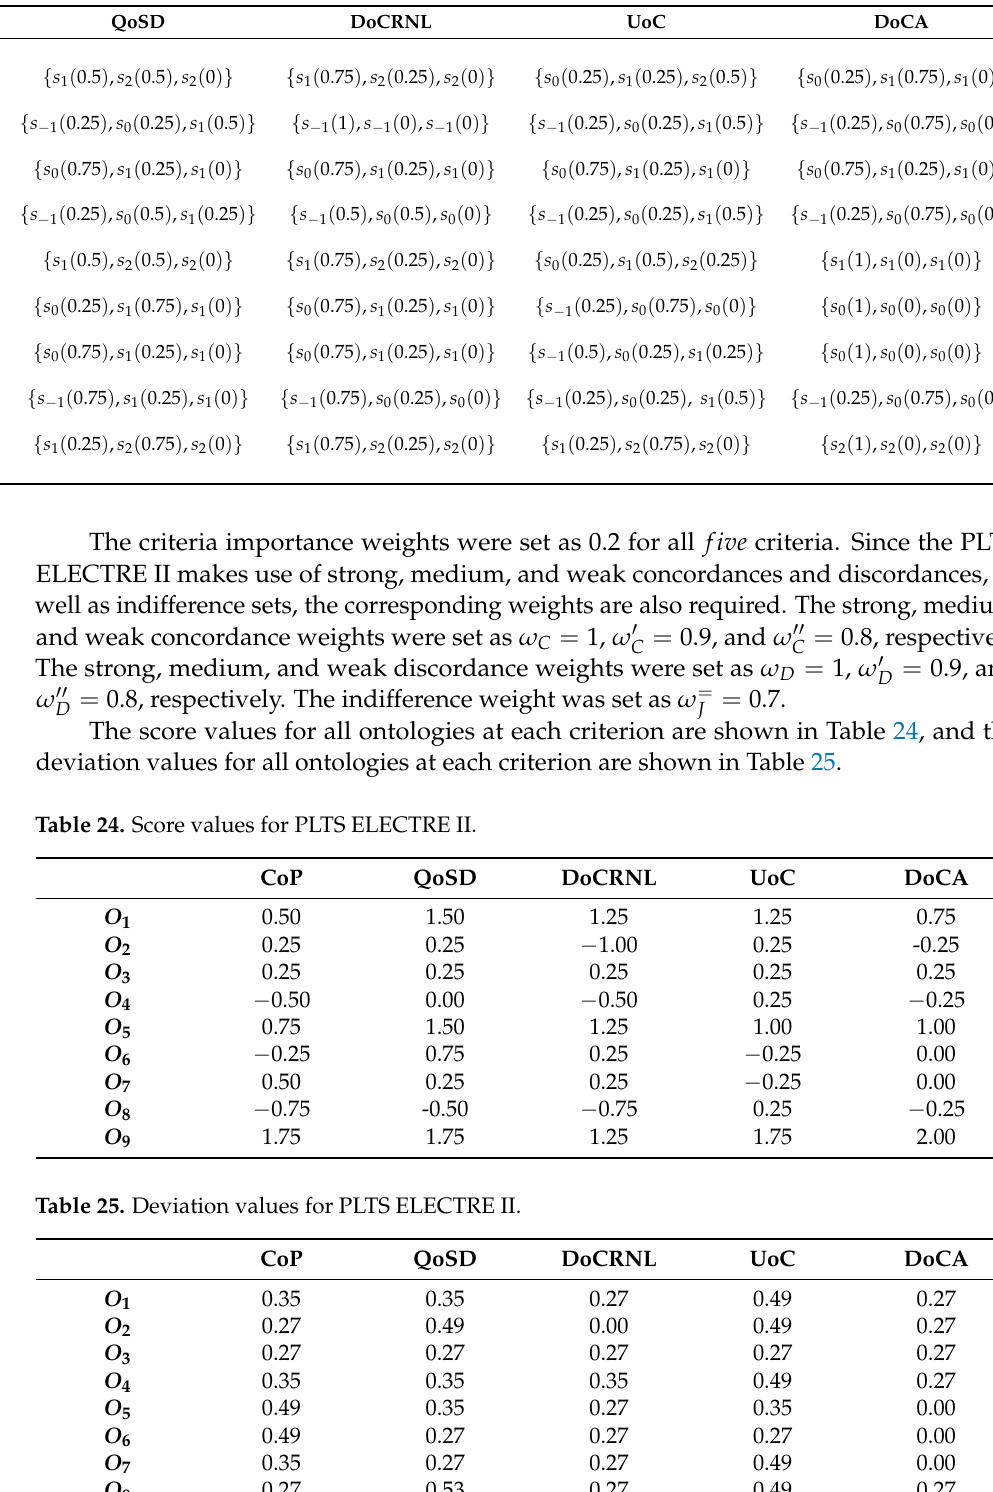
Table 23. Decision matrix for PLTS ELECTRE II.